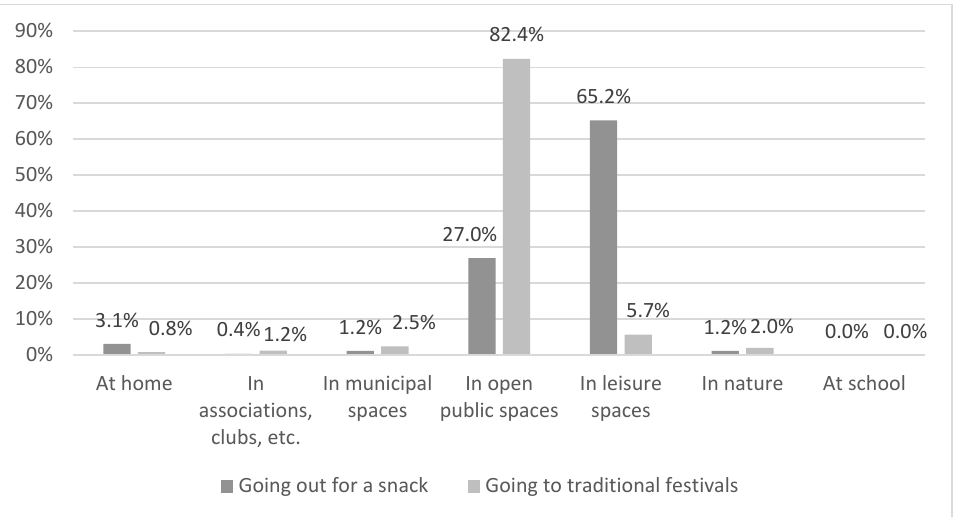
Figure 6. Places to practice festive leisure.